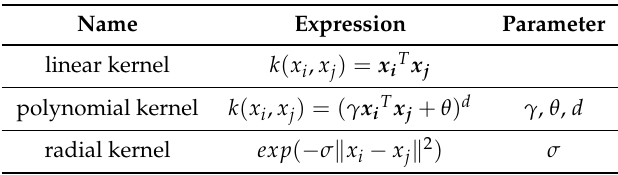
Table 11. Kernel